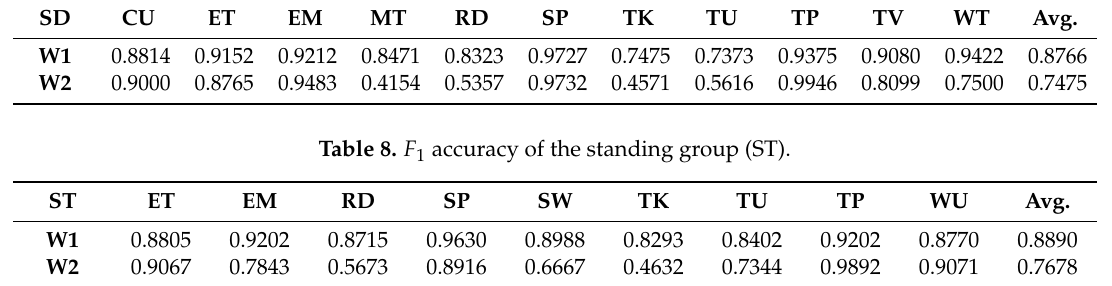
Table 7. F 1 accuracy of the sedentary group (SD).